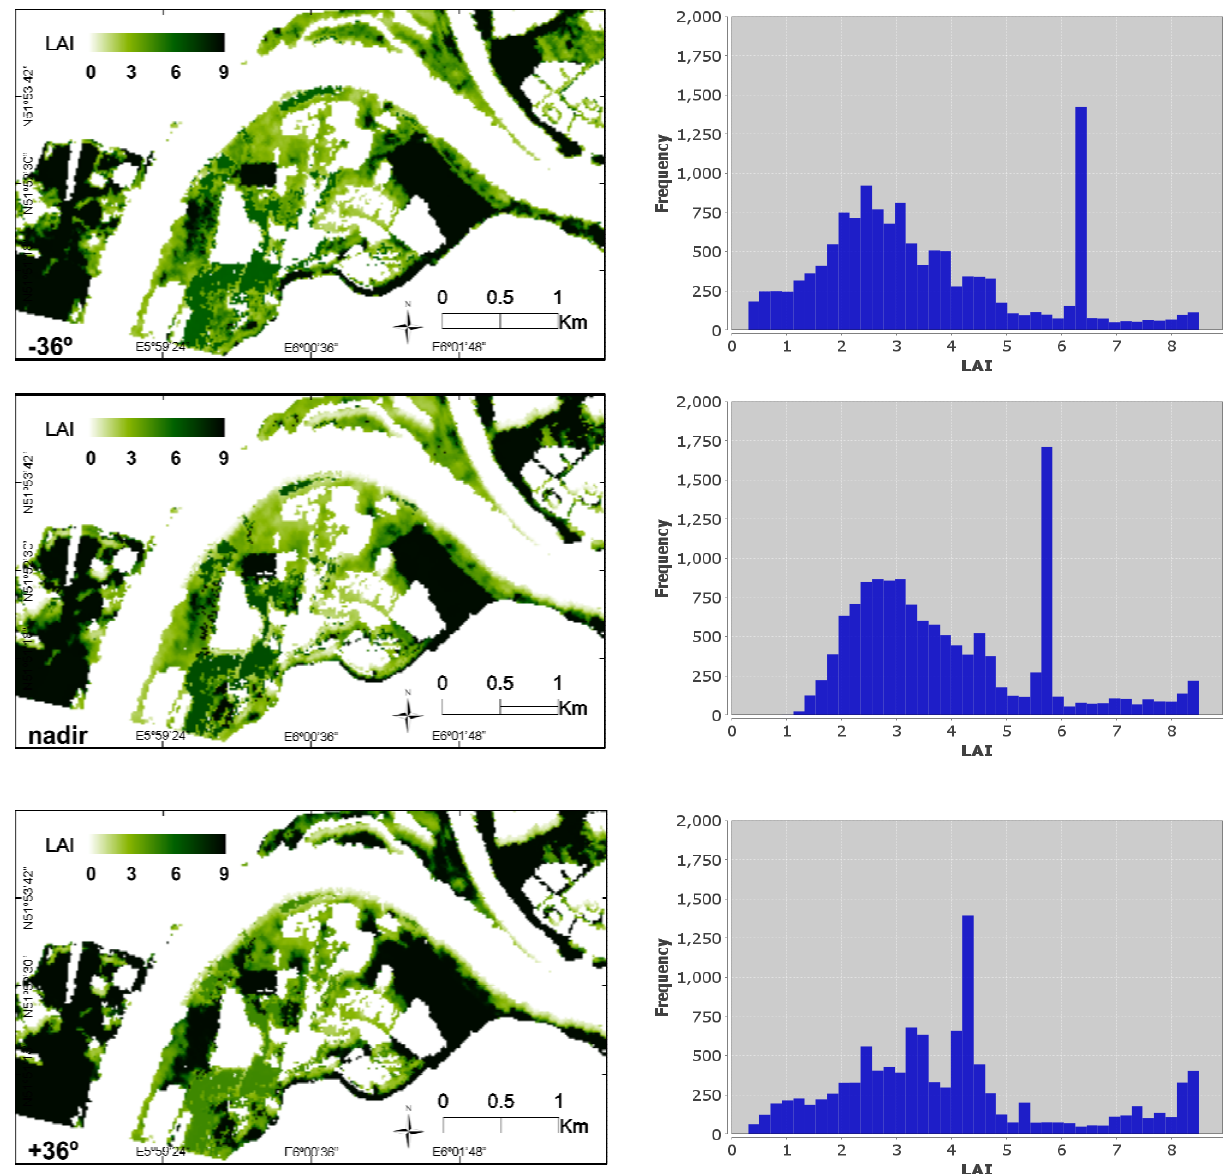
Figure 4. LAI maps ( left ) and derived histograms for LAI<8.5 ( right ) of Millingerwaard for the backward scattering direction ( − 36° VZA) ( top ), the nadir direction ( middle ) and the forward scattering direction (+36° VZA) ( down ), derived with FLIGHT model